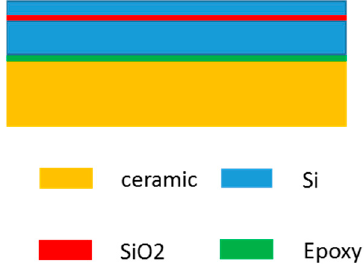
Figure 3. Five-layer model used for the numerical analysis.